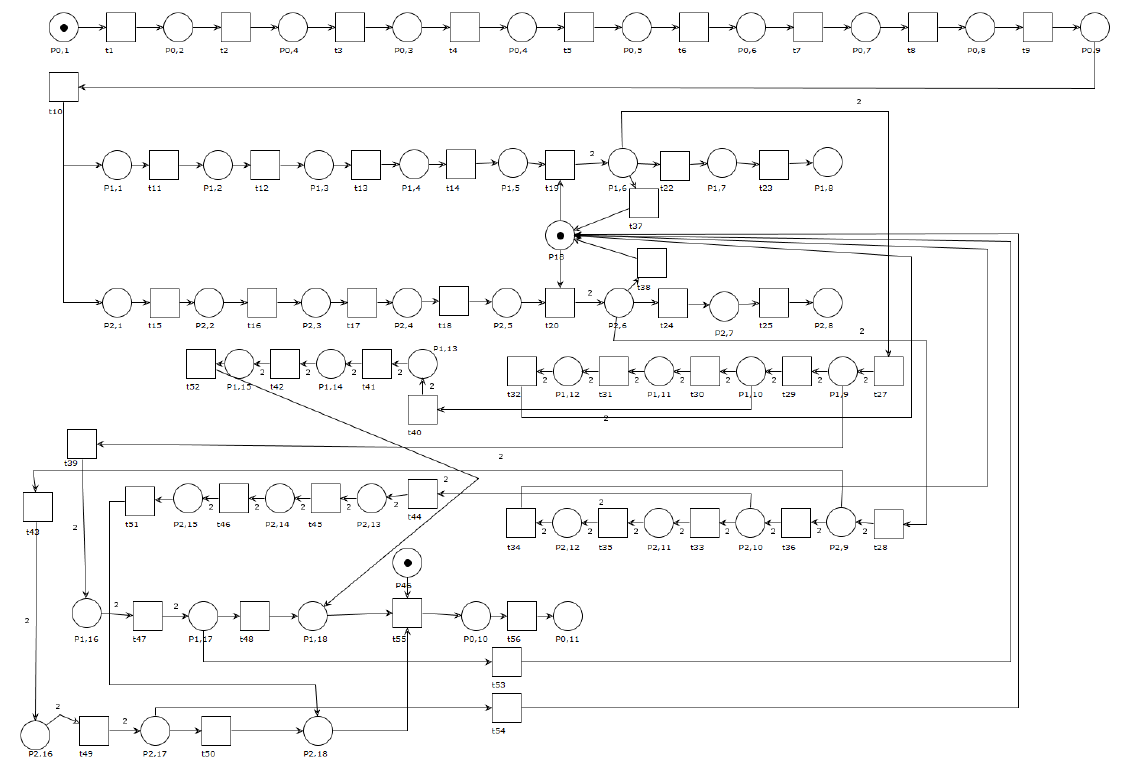
Figure 9. Petri net for the leading